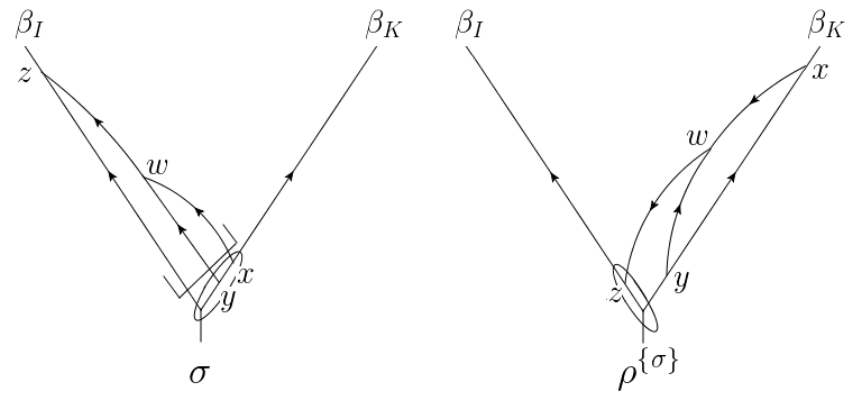
Figure 46. Another example on (cid:26) f (cid:27) g in position